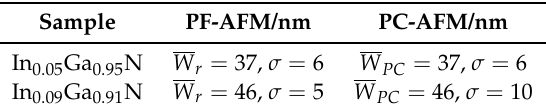
Table 2. Mean ridge widths ( W r ) and photocurrent drop widths ( W PC ) with corresponding standard deviations ( σ ) obtained from analysing PF-AFM topography and PC-AFM current maps of In 0.05 Ga 0.95 N and In 0.09 Ga 0.91